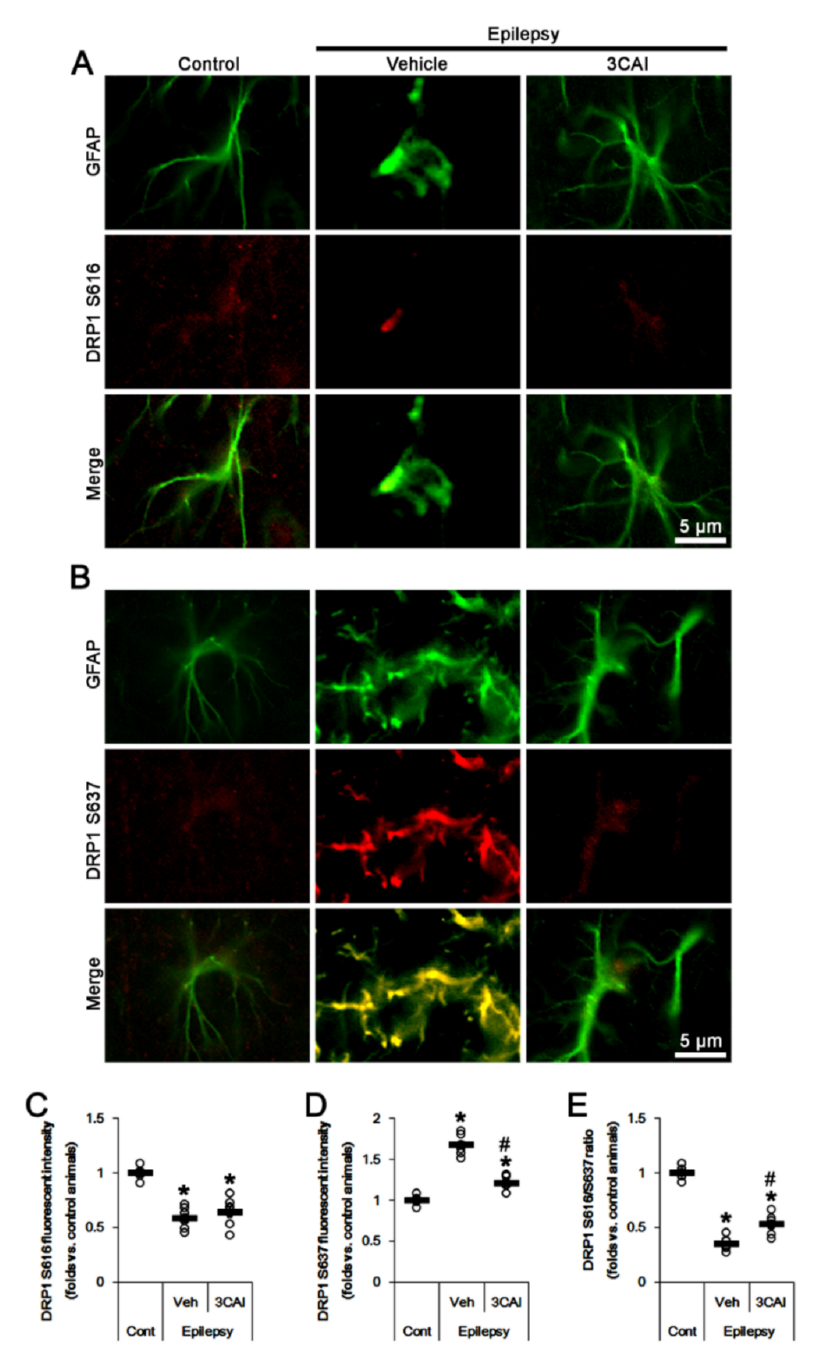
Figure 9. Effects of 3CAI on DRP1 S616- and S637 phosphorylations in CA1 astrocytes of control and epileptic rats. As compared to control animals (Cont), DRP1 S616 phosphorylation is reduced in CA1 astrocytes in epileptic rats, while DRP1 S637 phosphorylation is increased. 3CAI reduces the increased DRP1 S637 phosphorylation in CA1 astrocytes without affecting DRP1 S616 phosphorylation, as compared to vehicle (Veh). ( A , B ) Representative photos demonstrating astroglial DRP1 S616- ( A ) and S637 phosphorylation ( B ) in CA1 astrocytes. ( C – E ) Quantifications of DRP1 S616- ( C ), S637 phosphorylation ( D ) and DRP1 S616/S637 phosphorylation ratio ( E ) in CA1 astrocytes. Open circles indicate each value. Horizontal bars indicate the mean value. Error bars indicate SEM (*, # p < 0.05 vs. control and vehicle-treated epileptic rats, respectively; n = 7,